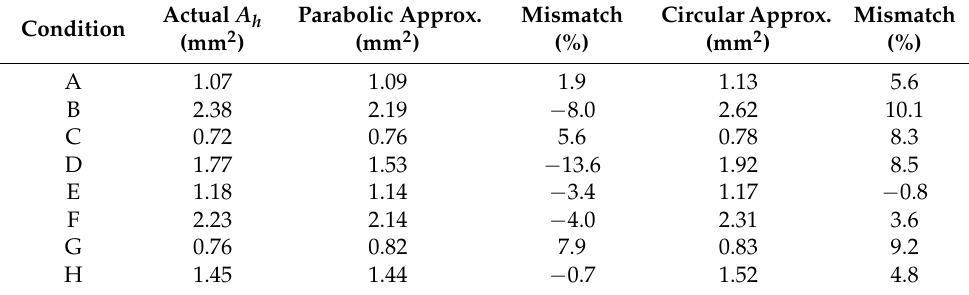
Table 6. Comparison between real and approximated fused area above the reference plane in the cross-section.